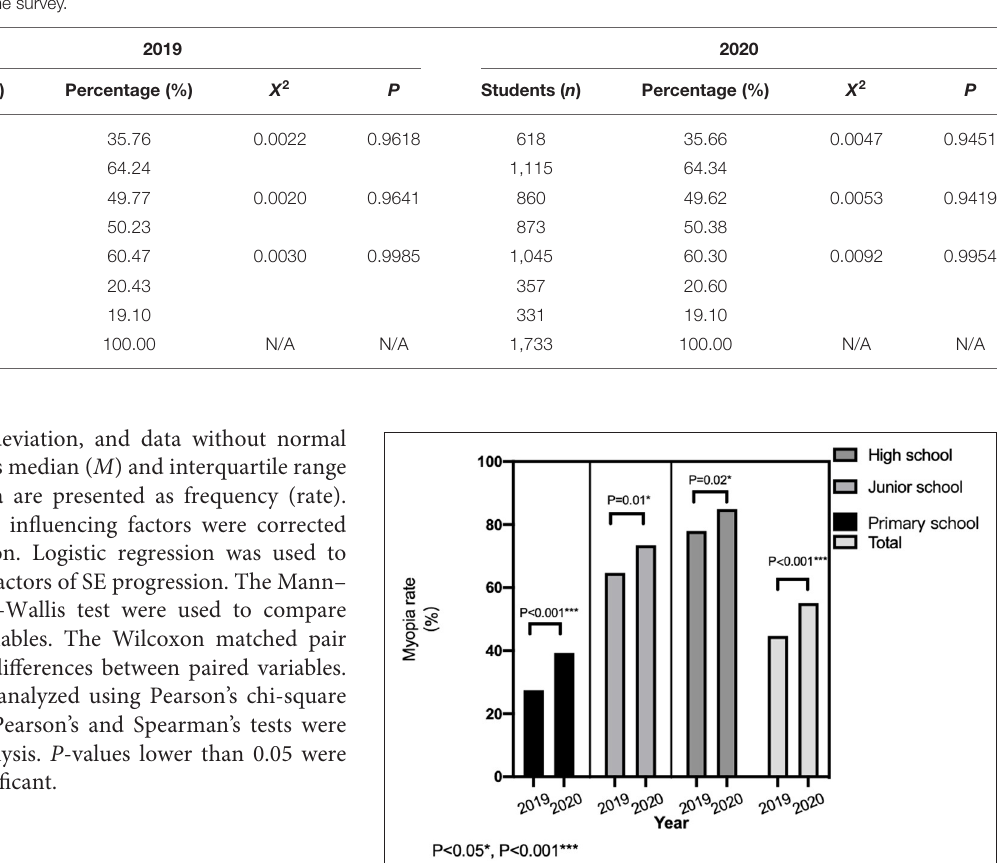
in high school, 73.39% in junior school, and 39.27% in primary school, which were significantly higher than those in 2019 ( P < 0.05; Figure 1